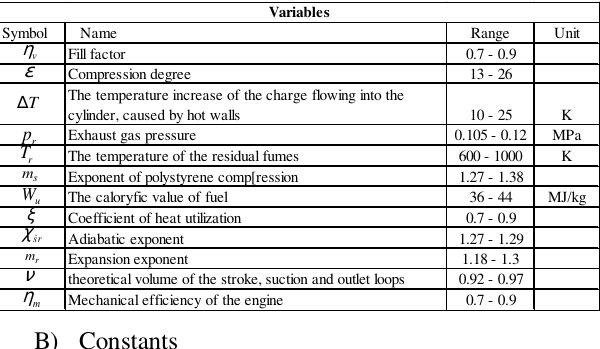
Table 1.Variables and ranges of their values